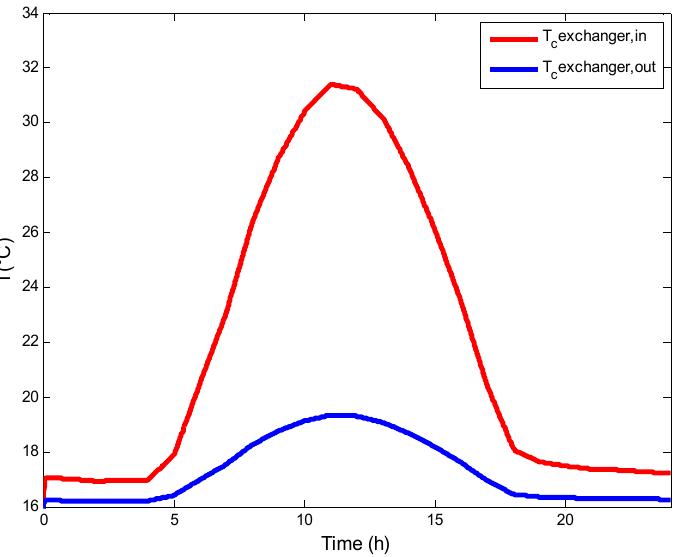
Figure 8. Saline water temperatures variation at the level of a plate heat exchanger with time.